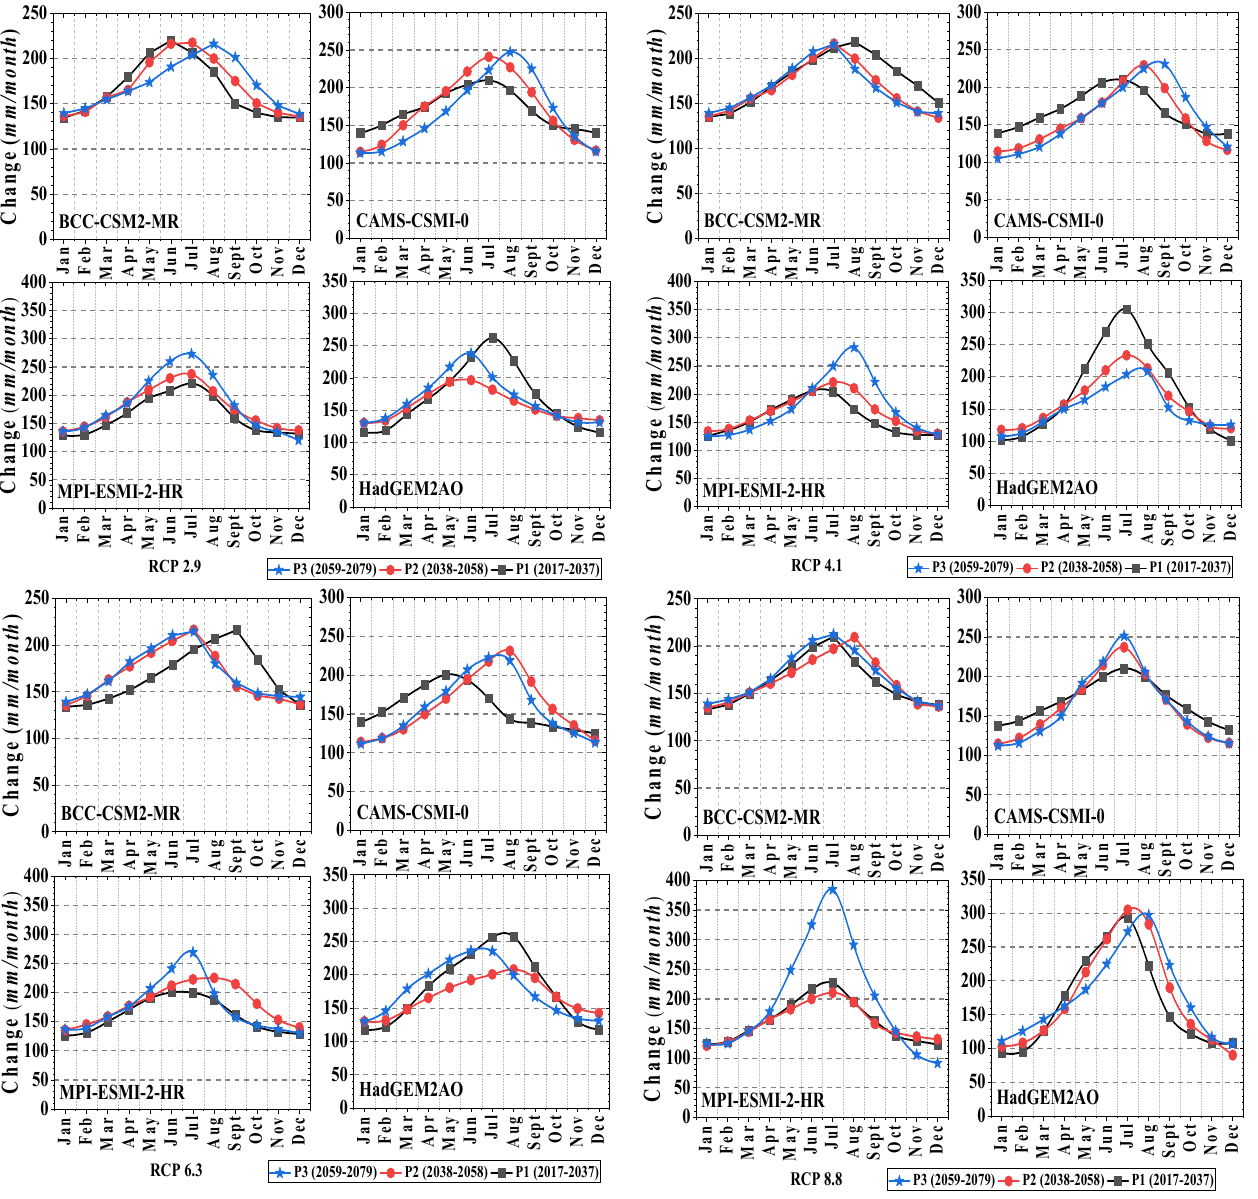
Figure 9. Projected climatology of discharges (mm/month) triggered with the deployed GCMs under the AR5-based emission scenarios.